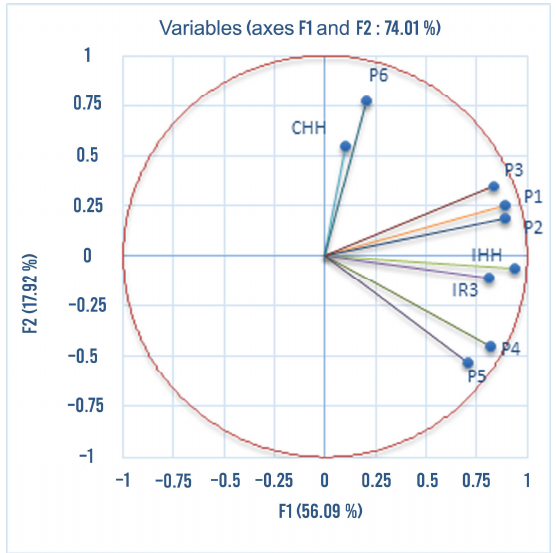
Figure 11. Principal component analysis applied on the five variables (IHH; IR3, CHH, P1, P2, P3, P4, P5, and P6).